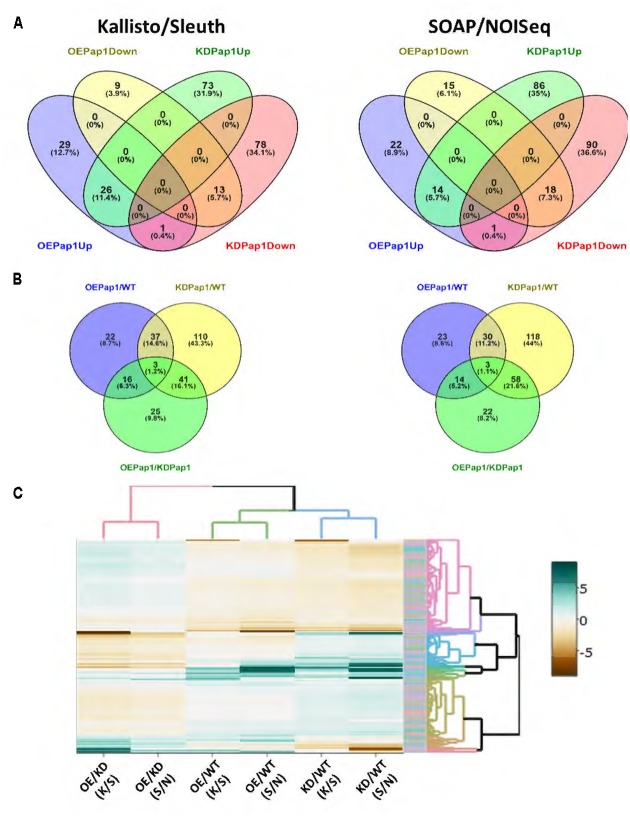
Differentially expressed genes (DEGs) in overexpressing (OE Pap1, 919) and silencing (KD Pap1, 1175) HvPap-1 transgenic lines. (A) Venn diagrams showing up and down regulated genes in OE Pap1 and KD Pap1 transgenic plants. (B) Venn diagrams show shared DEGs between different genotype comparisons. (C) Heatmap showing the expression levels in the different genotypes of all the obtained DEGs by Kallisto/Sleuth (K/S) and SOAP/NOISeq (S/N) analyses.